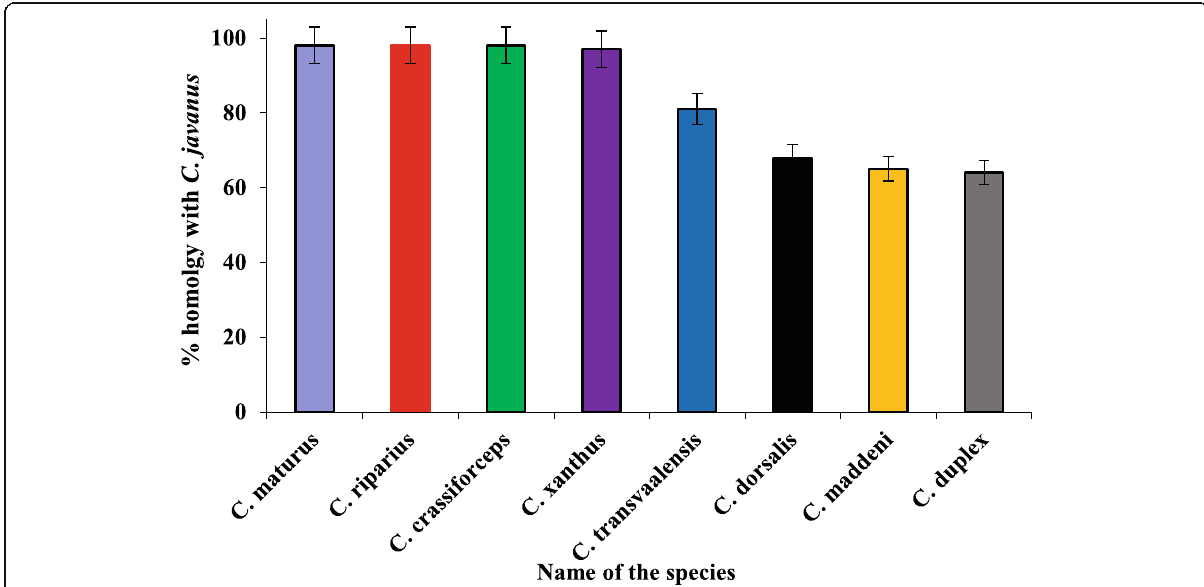
Fig. 1 Graphical presentation of % homology of DNA sequences (for 18S rRNA gene) of eight different species of Chironomus with C. javanus